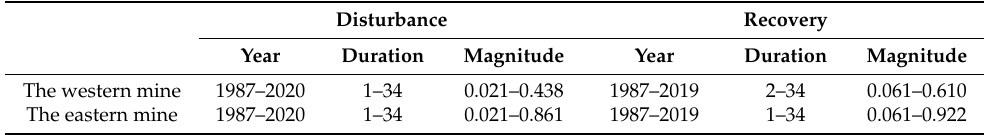
Table 2. Characteristics of disturbance and